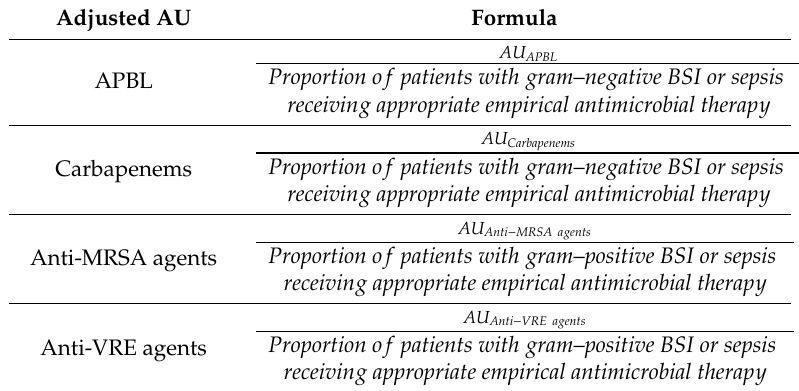
Table 1. Proposed novel metrics for adjustment of antimicrobial use by quality of care. Adjusted AU Formula AU APBL Proportion of patients with gram – negative BSI or sepsis APBL receiving appropriate empirical antimicrobial therapy AU Carbapenems Proportion of patients with gram – negative BSI or sepsis Carbapenems receiving appropriate empirical antimicrobial therapy AU Anti − MRSA agents Proportion of patients with gram – positive BSI or sepsis Anti-MRSA agents receiving appropriate empirical antimicrobial therapy AU Anti − VRE agents Proportion of patients with gram – positive BSI or sepsis Anti-VRE agents receiving appropriate empirical antimicrobial